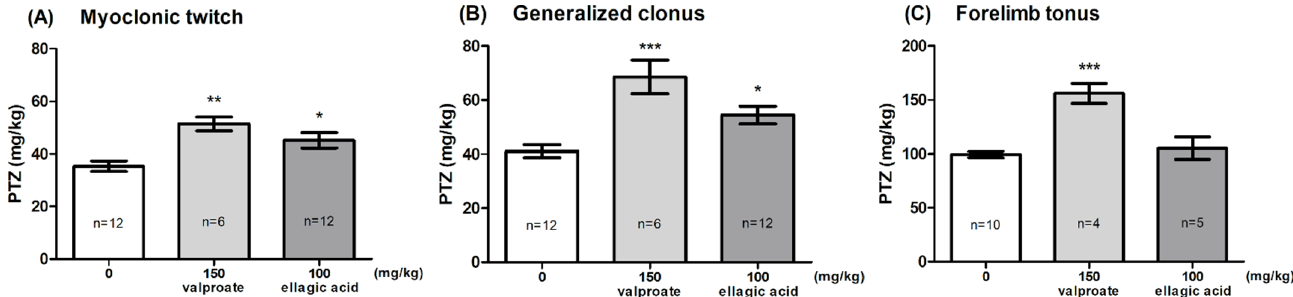
Figure 2. Effect of ellagic acid on the threshold for the onset of the first myoclonic twitch ( A ), generalized clonus ( B ), and forelimb tonus ( C ) in the i.v. PTZ seizure threshold test in mice. Ellagic acid and valproate (positive control) were injected i.p. 60 and 15 min before the test, respectively. The doses are shown on the abscissa. Control animals received 0.5% methylcellulose. Data are expressed as means (mg/kg PTZ) ± SEM. * p < 0.05, ** p < 0.01, *** p < 0.001 vs. the control group (one-way ANOVA followed by Dunnett’s post hoc